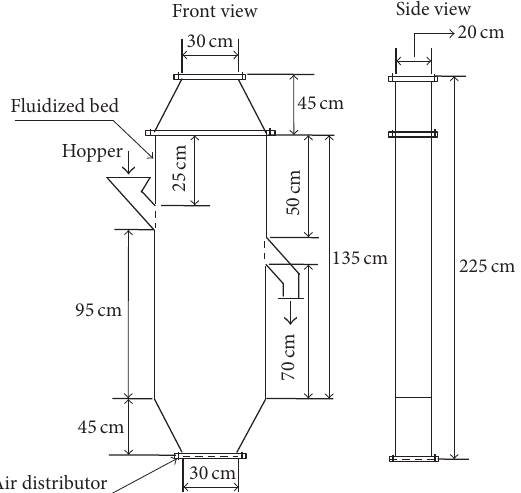
Figure 5: Dimensions of fluidized bed (drying chamber).